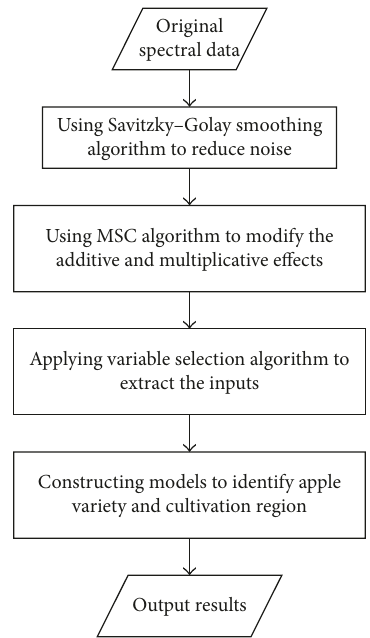
Figure 2: The flowchart of data